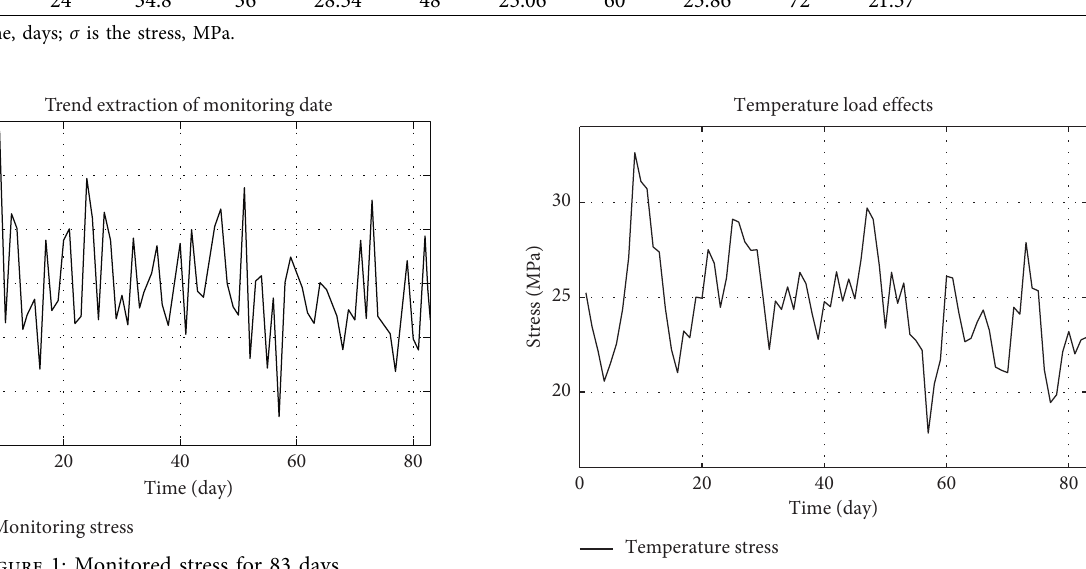
Figure 2: Decoupled temperature load effects for 83